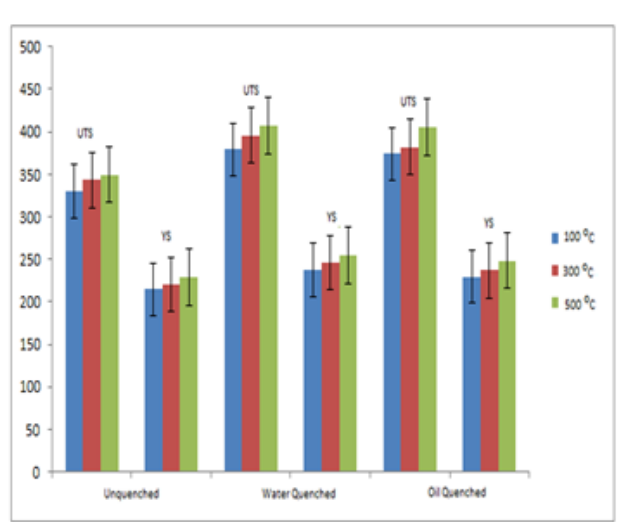
Fig. 1. Graph of UTS and YS of untreated and heated mild steel samples